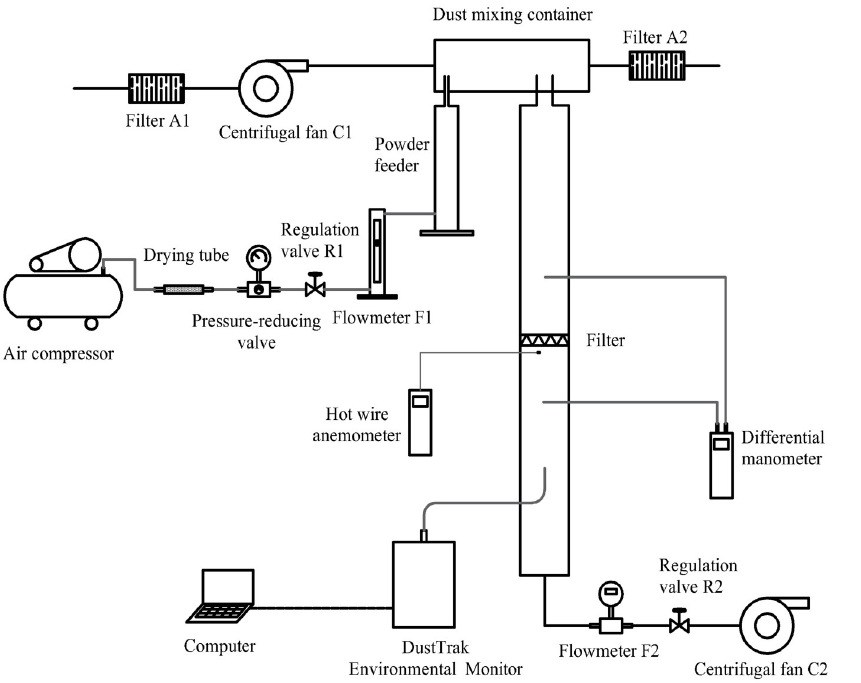
Fig 4. Schematic diagram of the experimental system.